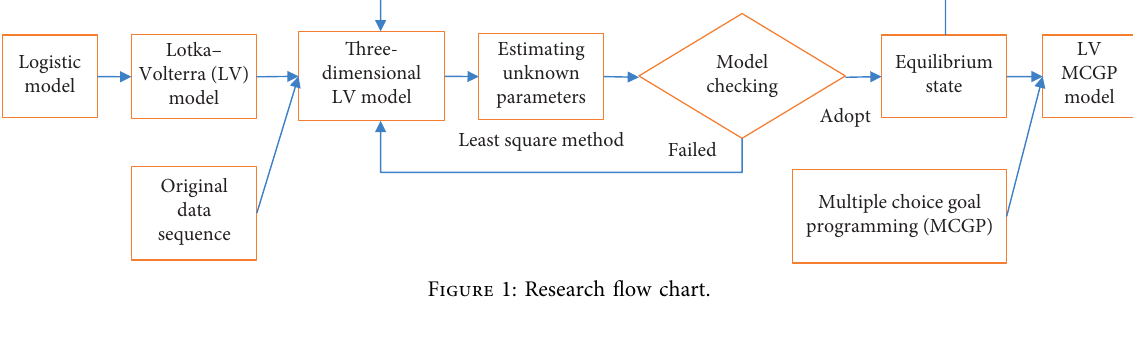
Figure 1: Research flow